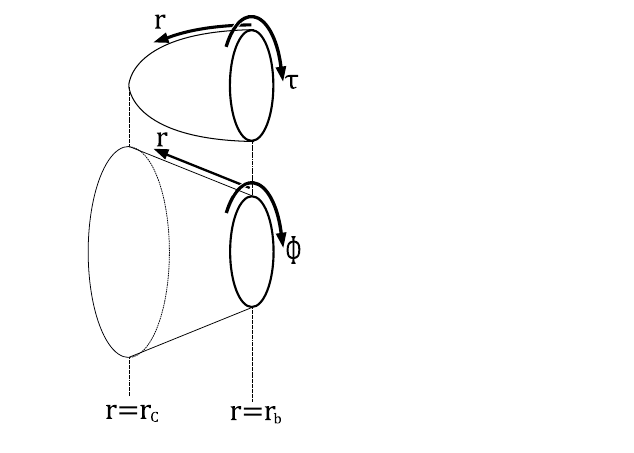
Figure 5 . Extra saddle point geometry of S 2 × D topology (BG instanton). The area of the bolt 4 πr 2 is larger than that of the boundary 4 πr 2 c on β . Branch 3D consists of this type of